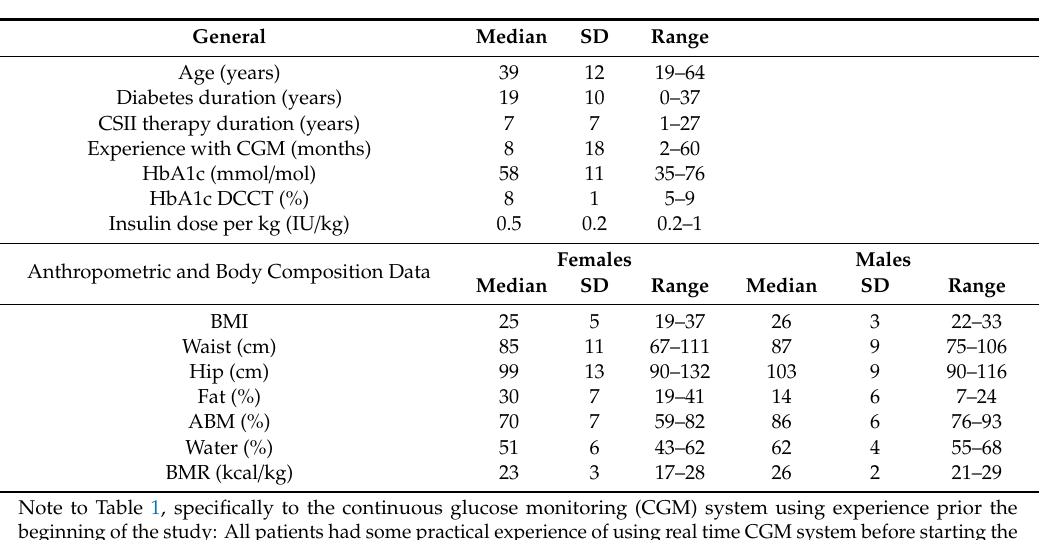
Table 1. Group characteristics.